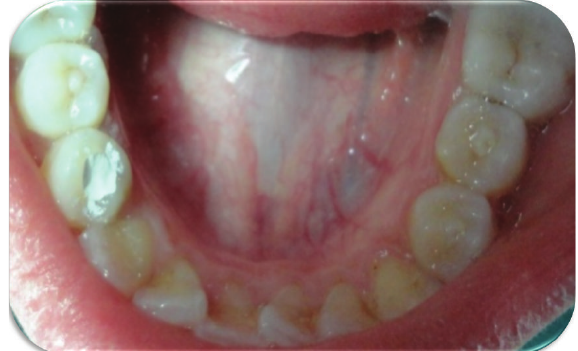
Figure 5: Microbiological culture showing gram positive cocci in clusters and in pair and short